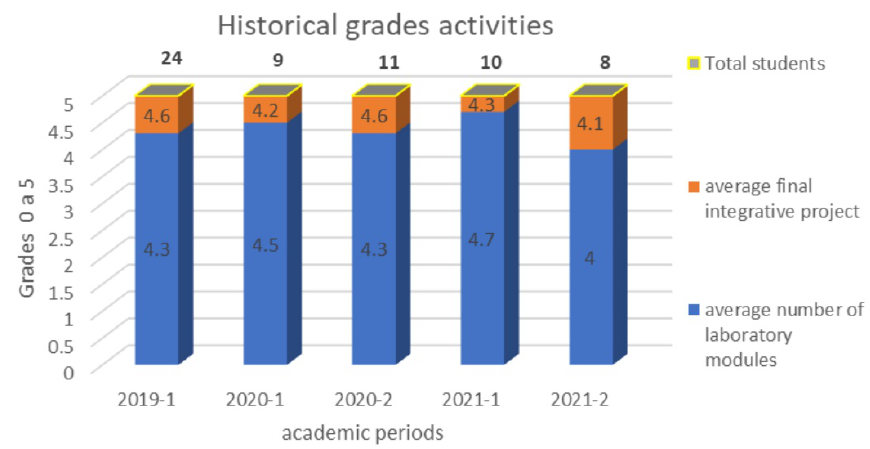
Figure 10. Average grades of undergraduate students in the last five academic periods.